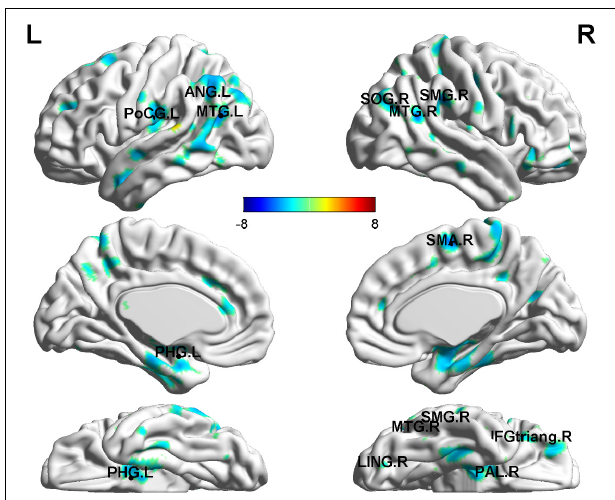
FIGURE 4 | Gray matter volume abnormalities associated with cg171674146 methylation. Correlation between whole-brain GMV and cg171674146 methylation in PD patients. The multiple regression analysis showed negative correlations with the left PHG, the bilateral MTG, the left ANG, the left PoCG, and so on. p < 0.01; N = 17.